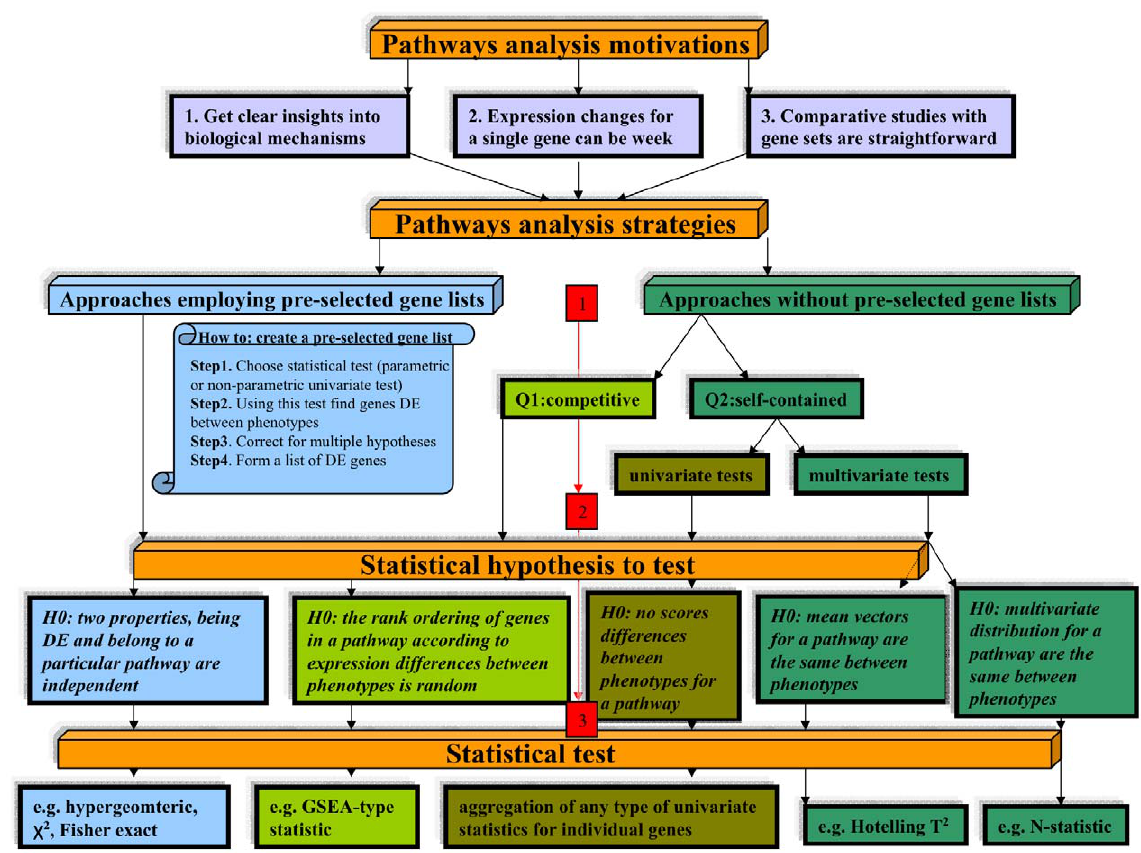
Figure 1. An overview of motivations and strategies, underlying statistical hypotheses and corresponding tests for pathway- analysis.